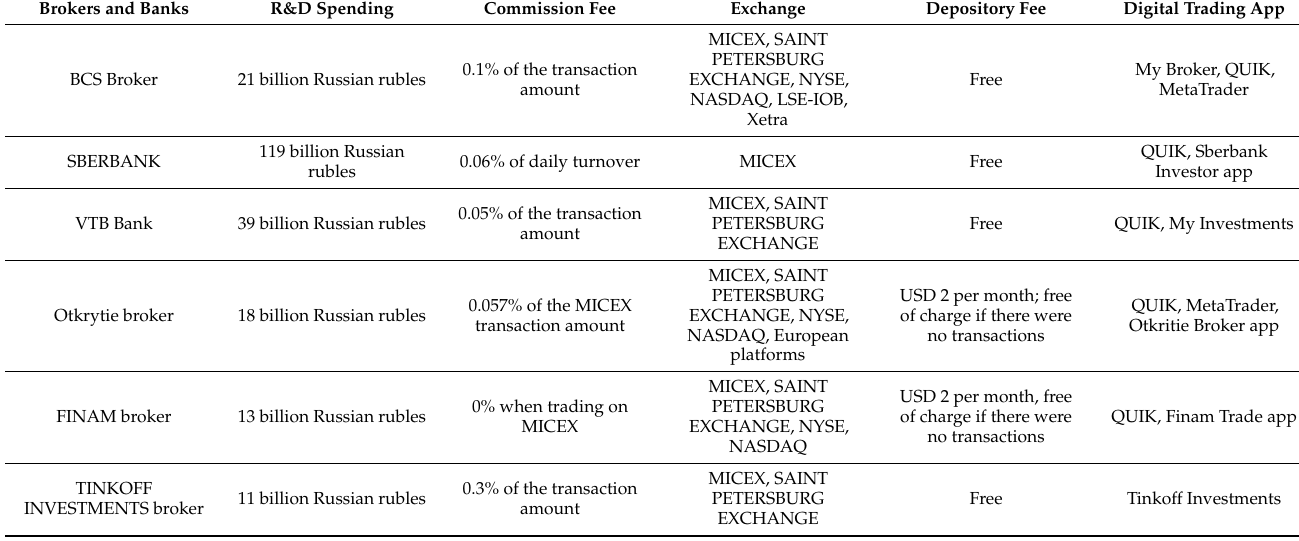
Table 6. Top players in the financial market (brokers and banks) in